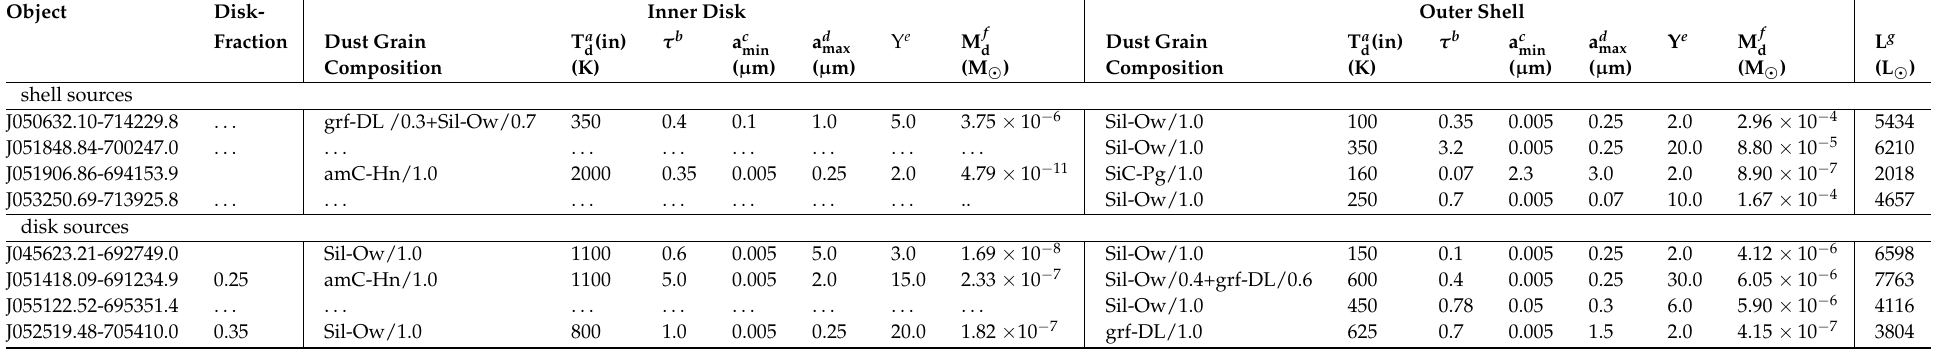
Table 2. Important parameters derived from the best–fit post-AGB